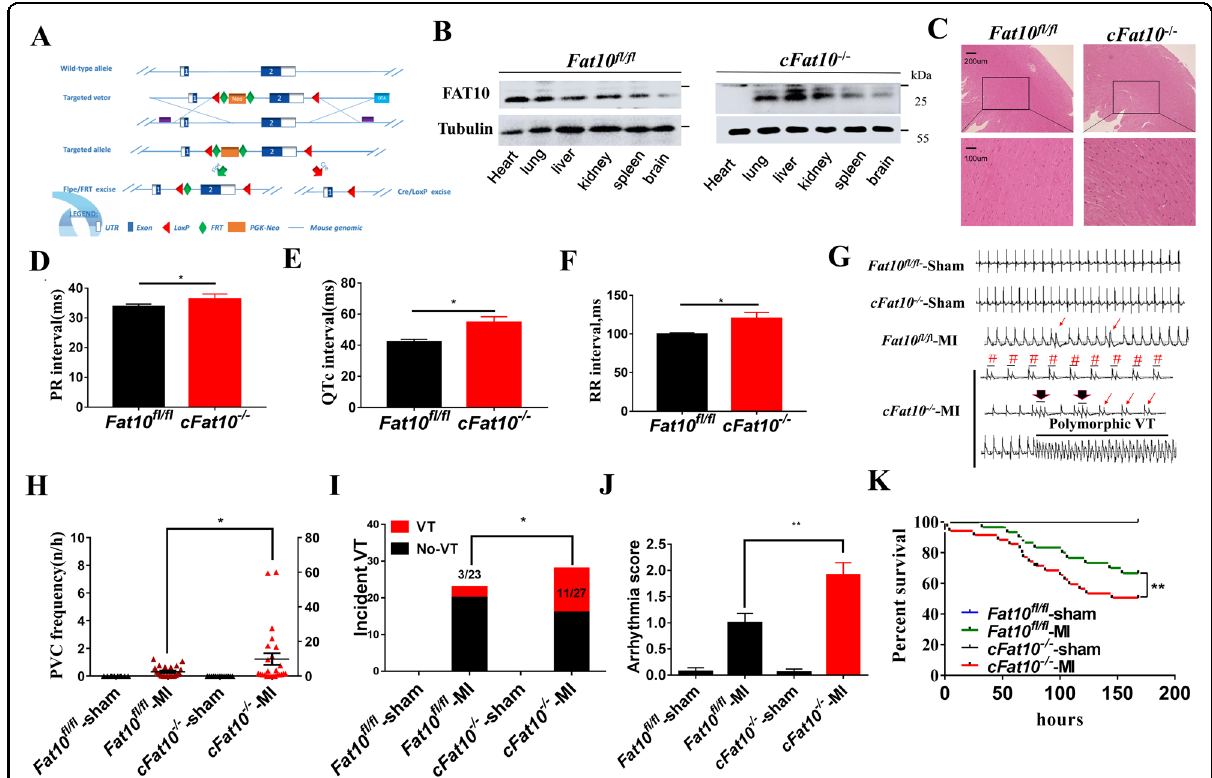
Fig. 1 Fat10 -de fi cient mice exhibit increased ventricular arrhythmia incidence and mortality rates after myocardial infarction (MI). A Schematic diagram of conditional cardiac Fat10 knockout ( cFat10 − / − ) generated by the homologous recombination technique. B Western blotting was performed to detect the expression of FAT10 in different tissues of cFat10 − / − mice and control littermates ( Fat10 fl / fl ). C Hematoxylin – eosin staining of mouse heart sections from cFat10 − / − mice and Fat10 fl / fl mice. D – F Analysis of electrocardiograph (ECG) parameters from cFat10 − / −